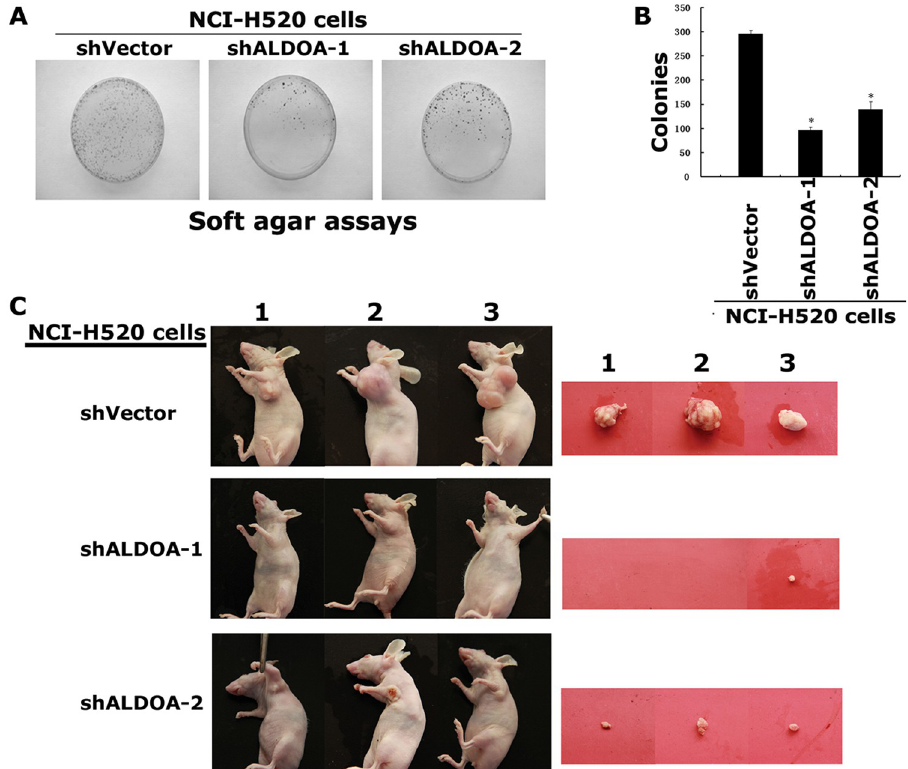
Figure 7. Depletion of ALDOA reduces the tumorigenicity of NCI-H520 cells. (A) Soft agar assays. The NCI-H520-siALDOA cells and NCI-H520-vector cells were suspended in single cell and cultured in soft agar to evaluate anchorage-independent colony formation. The experiments were done in triplates and repeated twice. The shVector panel in Figure 7A of [1] is reused as the NCI-H520 shRNA-NC panel in Figure 6B of [3]. (B) Data shows the average of the colonies formed by these NCI-H520 cells in triplicates. (C) The NCI-H520-shALDOA cells did not grow or only grow into very small tumors in the nude mice.